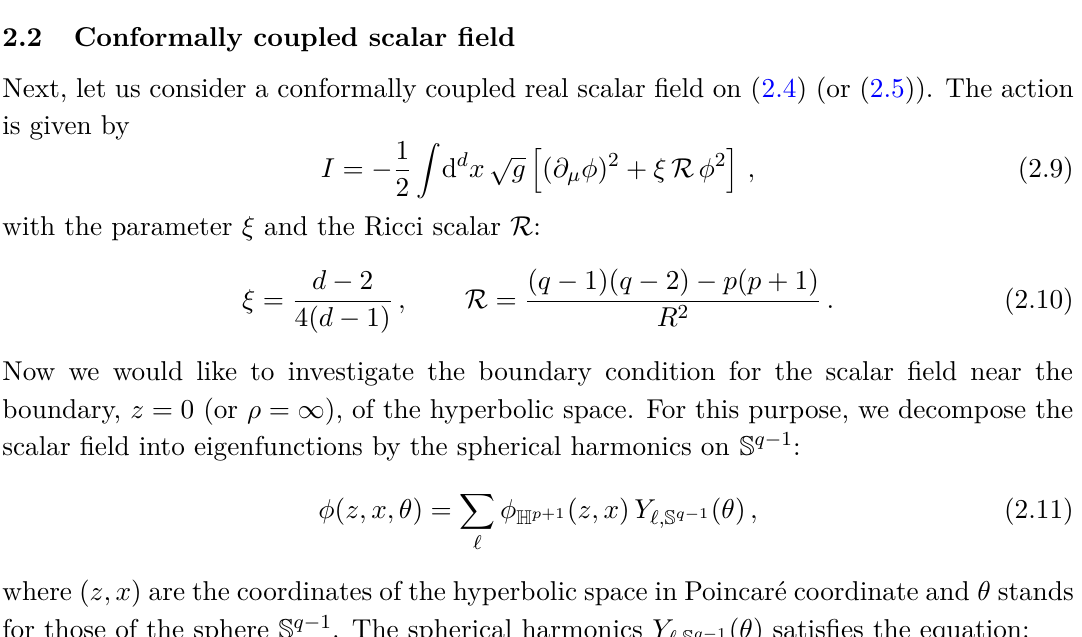
Figure 1 . Conformal map from flat space R d with a p -dimensional planar defect to H p +1 × S q − 1